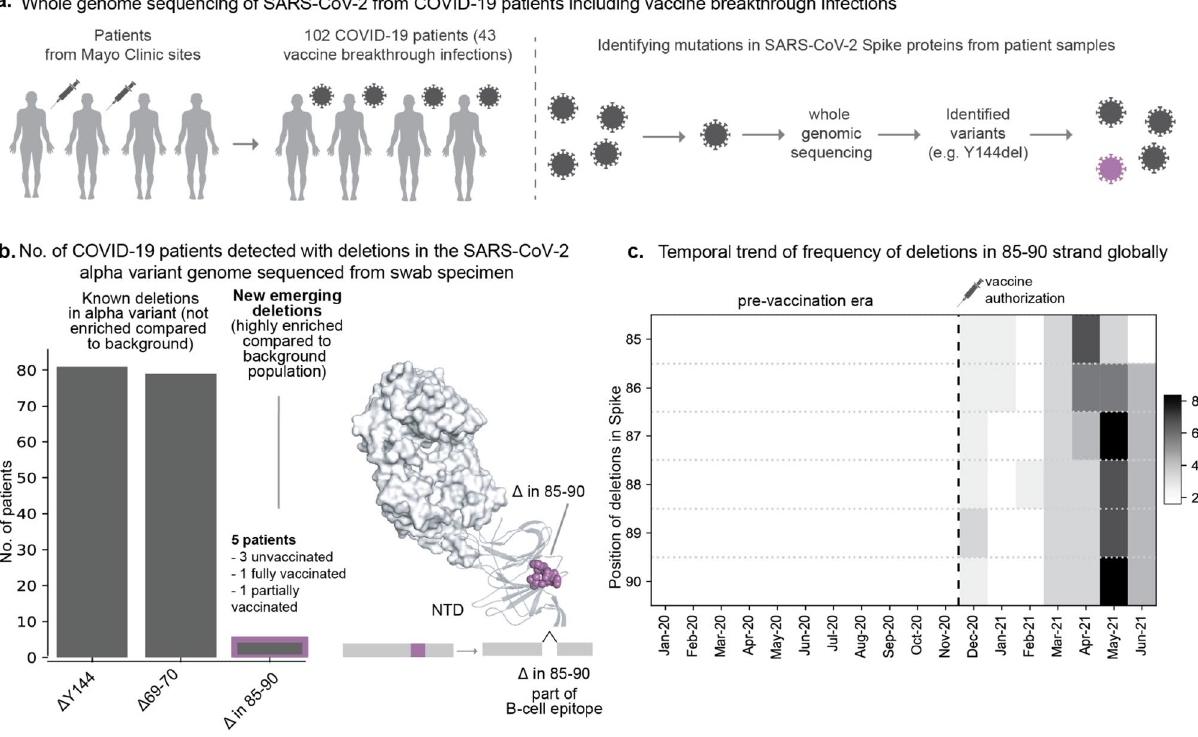
Figure 3. New deletion mutations present in the Spike proteins sequences derived from COVID-19 patients including vaccinated patients. ( a ) Whole genome sequencing of SARS-CoV-2 isolated from hospitalized COVID-19 patients or vaccination breakthroughs/reinfections from Mayo Clinic. ( b ) Barplot showing comparison of frequencies of deletions in patients infected with SARS-CoV-2 Alpha variant. New group of emerging deletions in the 85–90 region that is highly enriched compared to the background population is highlighted. The deletions in the other rarer lineages (e.g. Gamma variant) are not shown for clarity. The site of the emerging deletion mutations in patients is shown as spheres on the 3D structure of the Spike protein complexed with neutralizing antibody 4A8 (PDB identifier: 7C2L described by Chi et al. 18 , retrieved from the PDB). ( c ) Heatmap displaying temporal trend of increasing frequency of deletions corresponding to 85–90 region based on global SARS-CoV-2 genomic data from the GISAID database. The columns correspond to months and rows correspond to positions with deletions in the 85–90 region. The frequency of the mutations is mapped to a color scale of white to